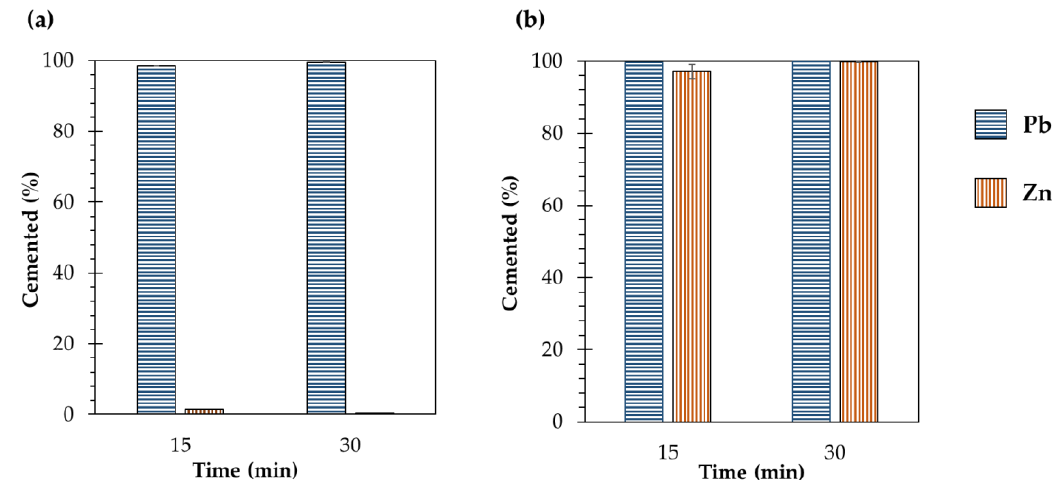
Figure 7. Amount of Pb and Zn cemented out using ZVAl in model experiments under ( a ) the simulated acidic chloride and ( b ) simulated alkaline solutions.